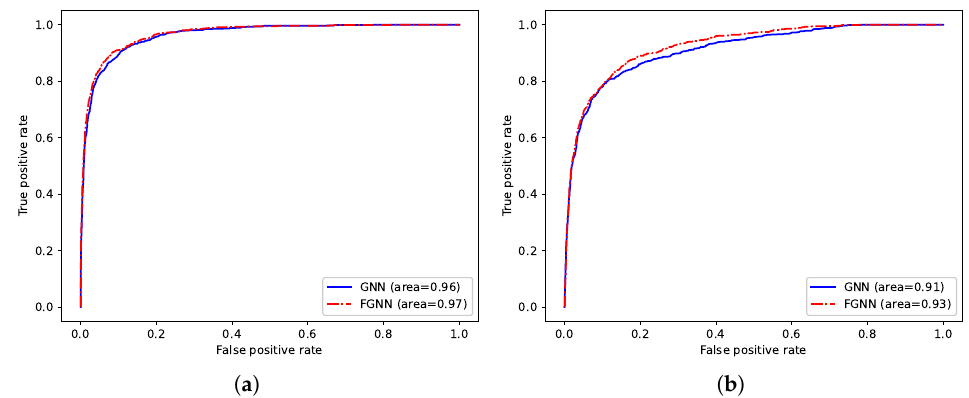
Figure 8. Testing ROC curves of GNN and FGNN on ( a ) Cora and ( b ) Citeseer. The horizontal axis denotes the false positive rate. The vertical axis denotes the true positive